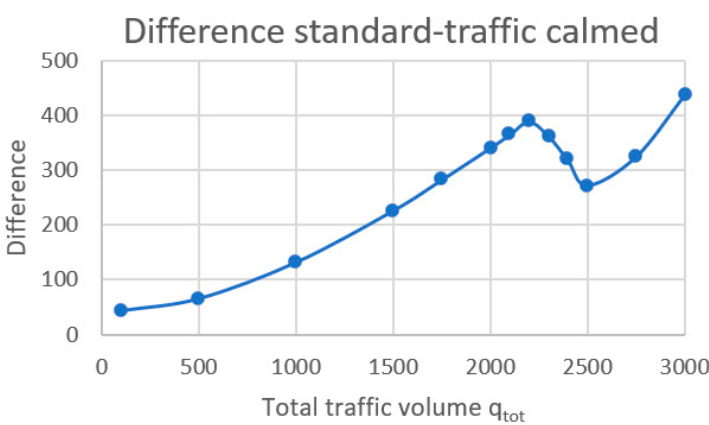
Figure 17. Difference in traffic flow on each link, source: own. The difference between the traffic volumes on links with the aforementioned volume– delay functions in relation to total traffic volume was modelled as a polynomial function + b . Function parameters are presented in Table 2. shown in Formula (4): di f f = c · q a tot Formula (5). Estimation function formula